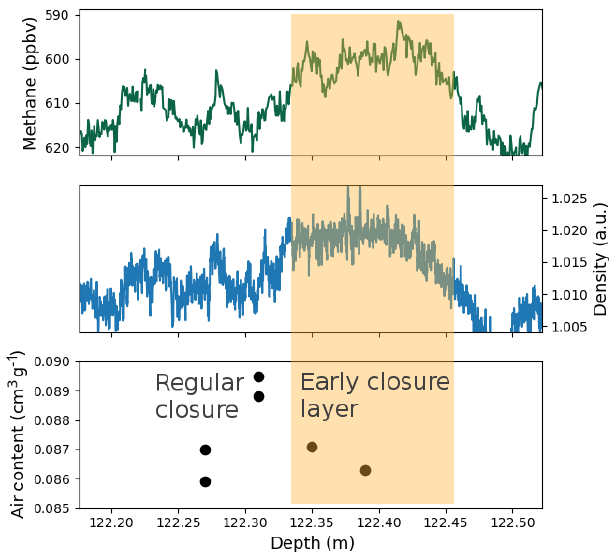
Figure 10. Example of an early closure layer highlighted by the orange shade. The reduced methane concentration around 122 . 40m is indicative of early gas trapping in the ice (reversed axis). This early closure layer is associated with high density values but air content values similar with the adjacent